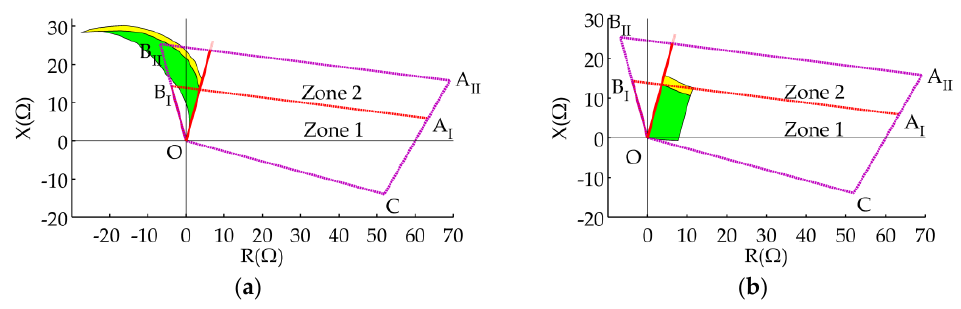
Figure 10. Areas of measured impedances of BC element in each relay under phase B-to-phase C faults on line mn ( P 0 “ 200MW and Q 0 “ 0MVar): ( a ) R1; ( b ) R2.